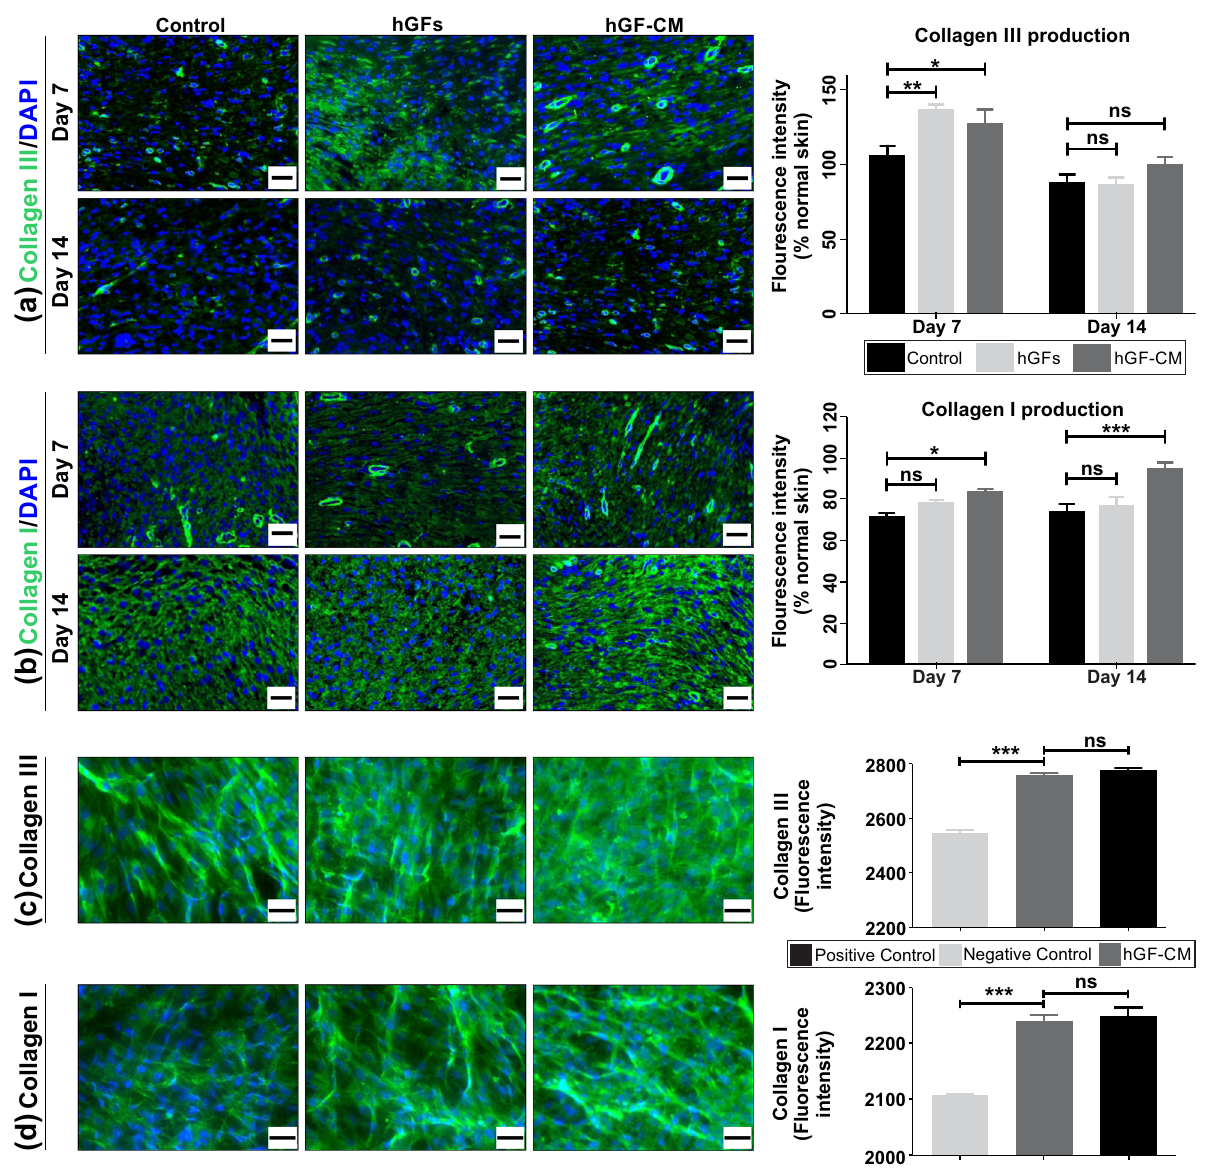
Fig. 5 The effect of hGFs and hGF-CM on collagen deposition. a , b Immuno fl uorescent detection and quanti fi cation of ( a ) collagen III or ( b ) collagen I (green) counterstained with DAPI in hGF and hGF-CM treated and control wounds. Images captured at ×20 objective. Scale bars represent 0.2 mm. n = 8. c , d Immuno fl uorescent detection and quanti fi cation of ( c ) collagen III or ( d ) collagen I (green) expression in HFFs treated with hGF-CM and control media. Fluorescence intensities measured using CellSens dimension software. Images captured at ×20 objective. Scale bars represent 0.5 mm. n = 6. All data are represented as mean ± SEM. * p < 0.05, ** p < 0.01, *** p < 0.001, ns = nonsigni fi